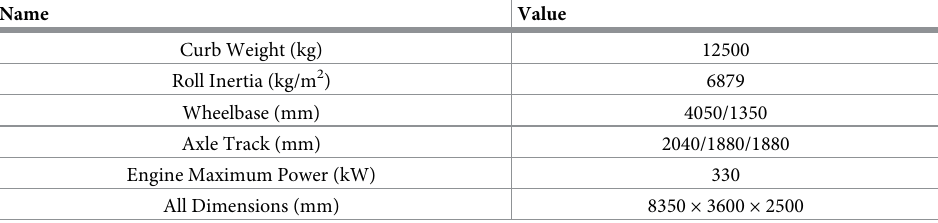
Table 1. Experimental vehicle